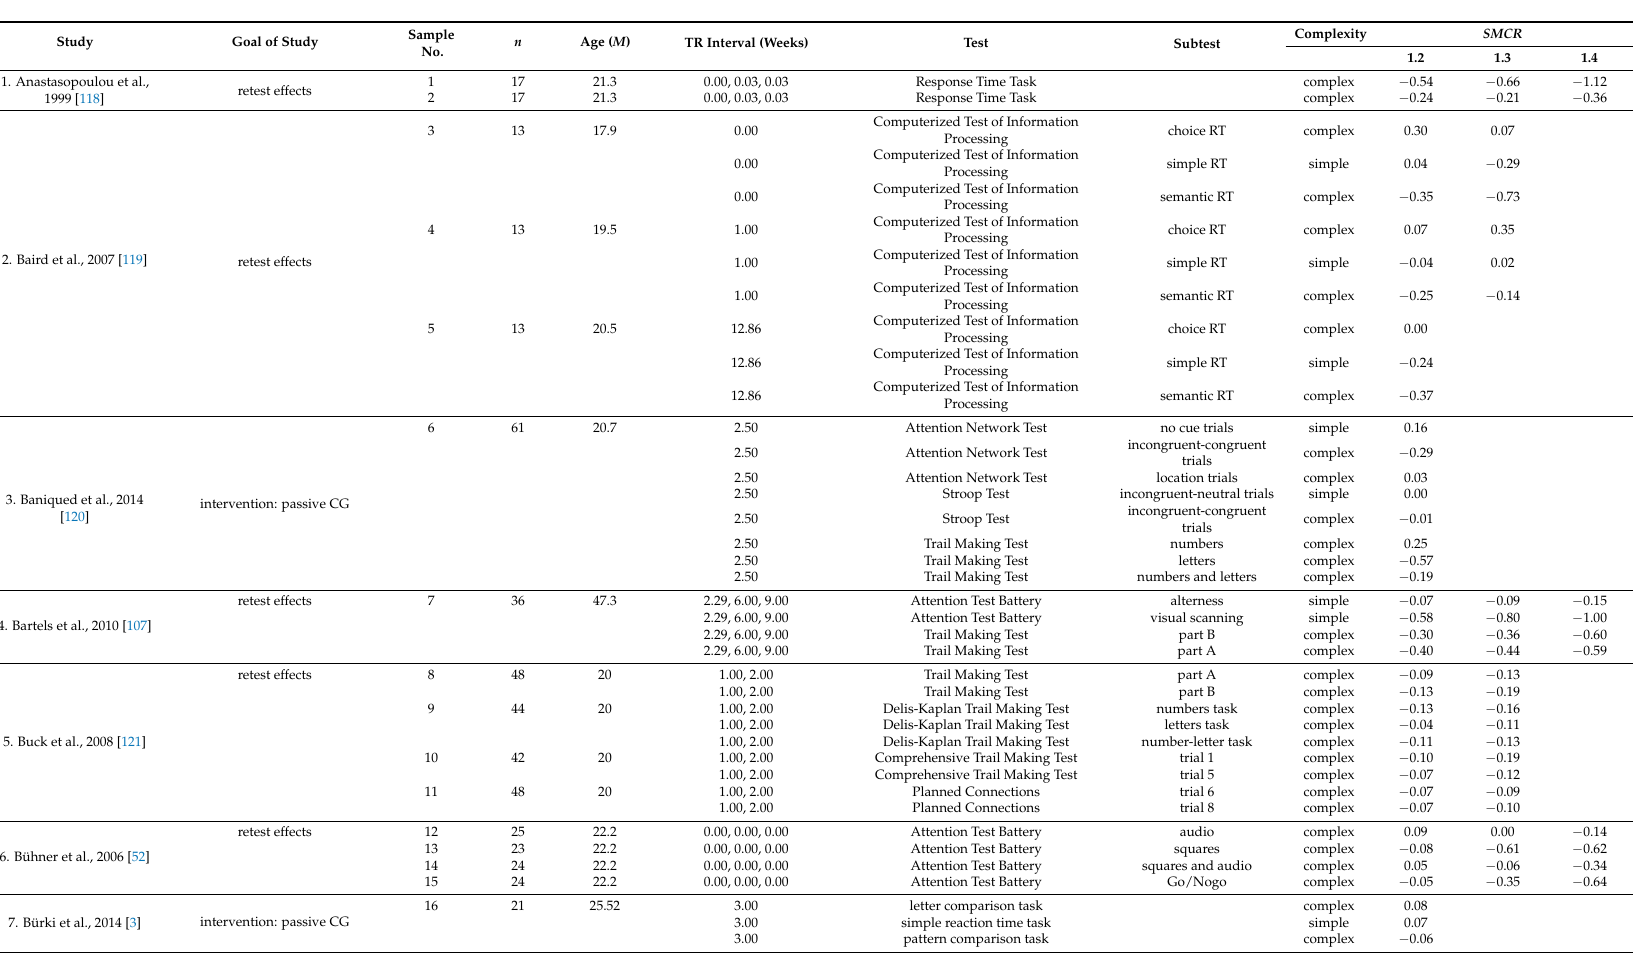
Table A1. List of Eligible Studies, their Main Characteristics and Effect